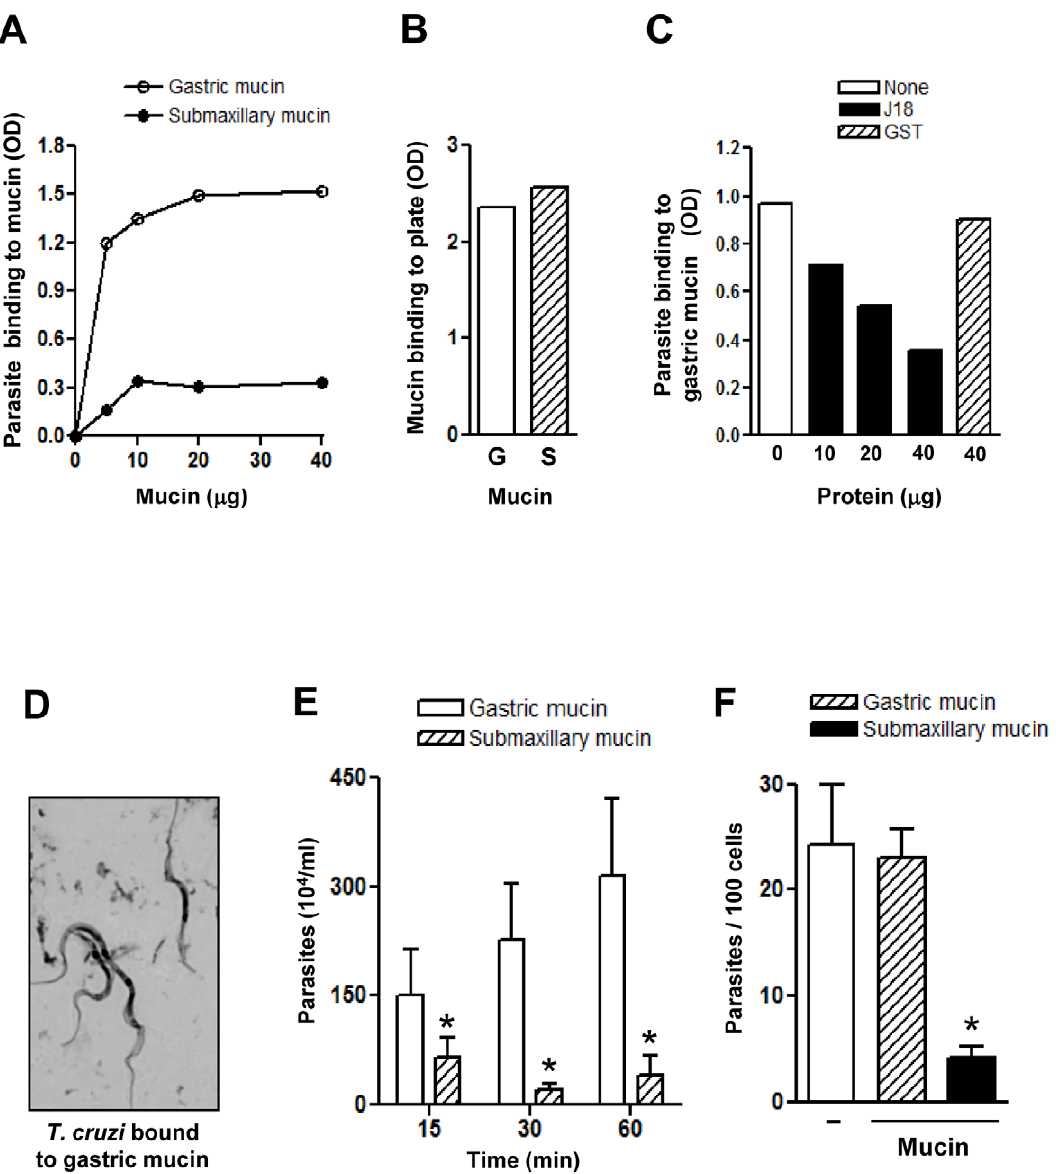
Figure 1. Selective binding of T.cruzi metacyclic trypomastigotes to gastric mucin. A) Microtiter plates coated with varying amounts of gastric or submaxillary mucin were incubated with metacyclic forms for 1 h and processed for detection of bound parasites by ELISA. Values are the means of triplicates of one representative assay out of three. Variation between triplicates was , 5%. B) Microtiter plates coated with gastric (G) or submaxillary (S) mucin (10 m g/well) were processed for ELISA using antibodies specific for gastric or submaxillary mucin at 1:100 dilution. Values are the means of triplicates (variation , 5%). C) Metacyclic forms were added to microtiter plates coated with gastric mucin (10 m g/well) and incubated in absence or in the presence of the indicated amounts of the recombinant protein J18 or GST and processed for ELISA. Values are the means of triplicates. (variation , 10%). D) Metacyclic trypomastigotes were added to gastric mucin-coated coverslips and, following the procedure described in the methods section, the Giemsa-stained parasites were visualized under the microscope. E) Transwell filters coated with gastric or submaxillary mucin were placed onto wells containing metacyclic forms. At different time points, samples from the filter chamber were collected and the number of parasites counted. Values represent the means 6 standard deviation of three independent experiments. The difference in parasite translocation through gastric and submaxillary mucin layer was significant (*), with P , 0.05. F) Gastric or submaxillary mucin was added to HeLa cells before addition of metacyclic trypomastigotes. After 1 h at 37 u C, the cells were fixed and Giemsa-stained. The number of internalized parasites was counted in a total of 250 cells. Values correspond to means 6 SD of 4 independent experiments. There was a significant difference between invasion in absence and in the presence of submaxillary mucin (*), P , 0.01. coat microtiter plates for J18 binding assays. As shown in Fig. 2C, carboxy-terminal half of gp82 and J18*, lacking 65 residues (amino J18 bound efficiently to gastric mucin regardless of the pH. To acids 257 to 321) corresponding to the gp82 domain required for determine the gastric mucin-binding domain of the gp82 molecule, host cell adhesion (Fig. 2D). J18* did not bind to gastric mucin, in two other recombinant proteins were used: J18b, containing the contrast to J18 and J18b (Fig. 2E).